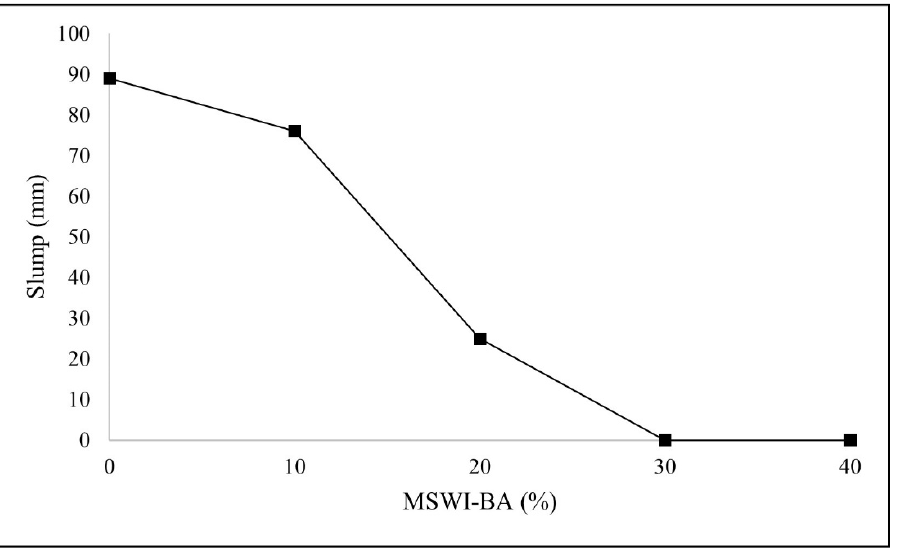
Figure 3. Slump of cement mortar containing MSWI-BA, with data from